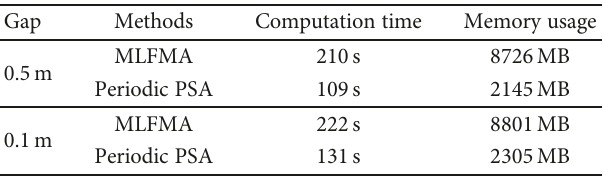
Figure 2: Radar cross sections (V-V polarization) of the 4 × 5 sphere array with (a) 0.5m and (b) 0.1 m gap computed by FEKO, MLFMA, and periodic PSA. The incident plane wave angles satisfy θ = 0 ° and φ = 0 ° . The scattering angles work with θ varies from 0 ° to 360 ° and φ = 0 ° . Table 1: Computation time and memory usage of MLFMA and periodic PSA for scattering of 4 × 5 elements.